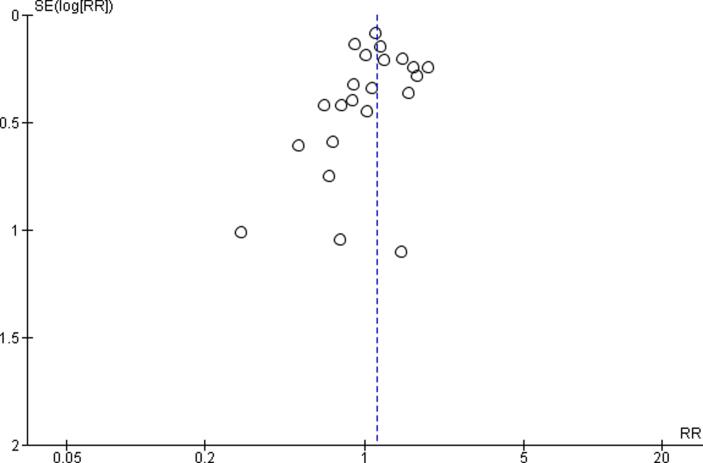
Funnel plot or prioritized evidence (cohort studies), Outcome: Acquired ischaemic heart disease, Comparison: Worked ≥55 h/week compared with worked 35–40 h/week.